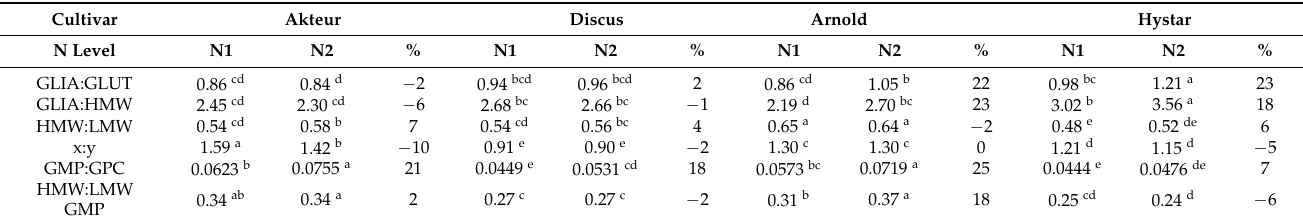
Table 4. Effect of N2 on gliadin to glutenin ratio (GLIA: GLUT), gliadin to HMW-GS ratio